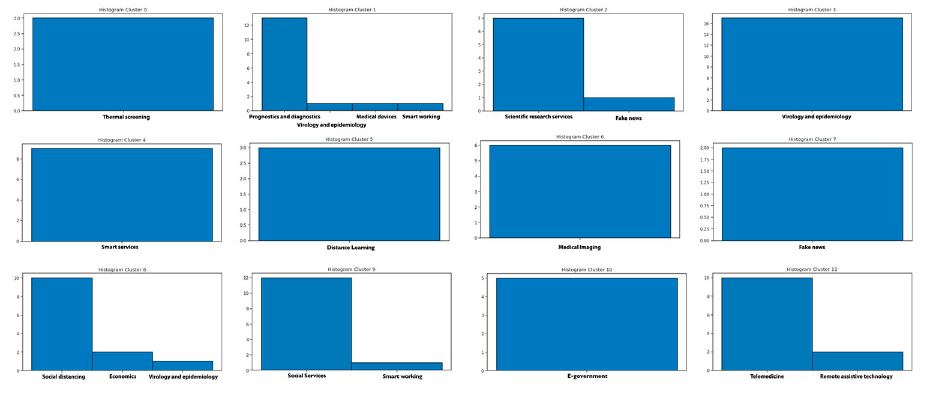
Fig 22. Details of clusters for